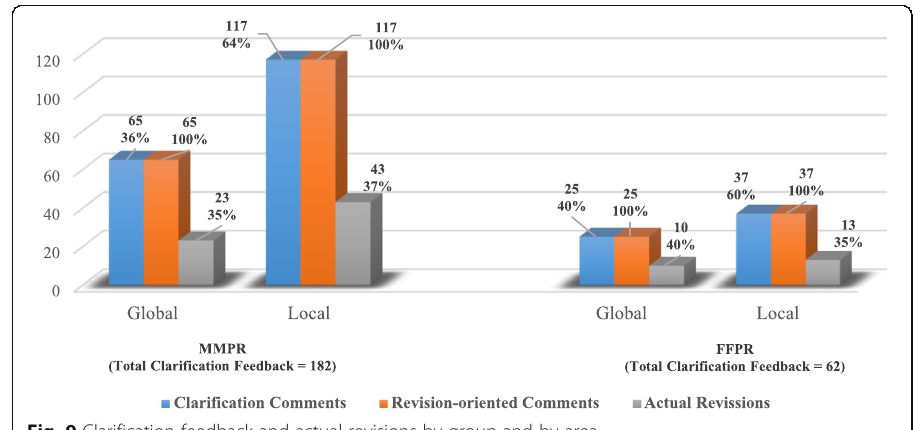
Fig. 9 Clarification feedback and actual revisions by group and by